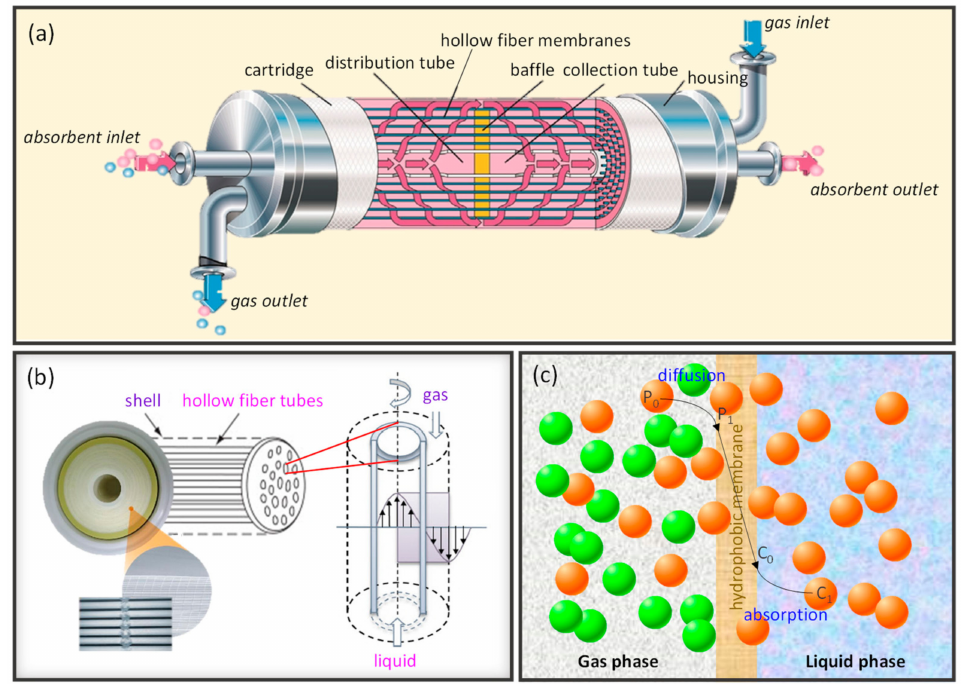
Figure 16. ( a ) Shell-and-tube module of a membrane contactor. ( b ) Hollow fiber configuration